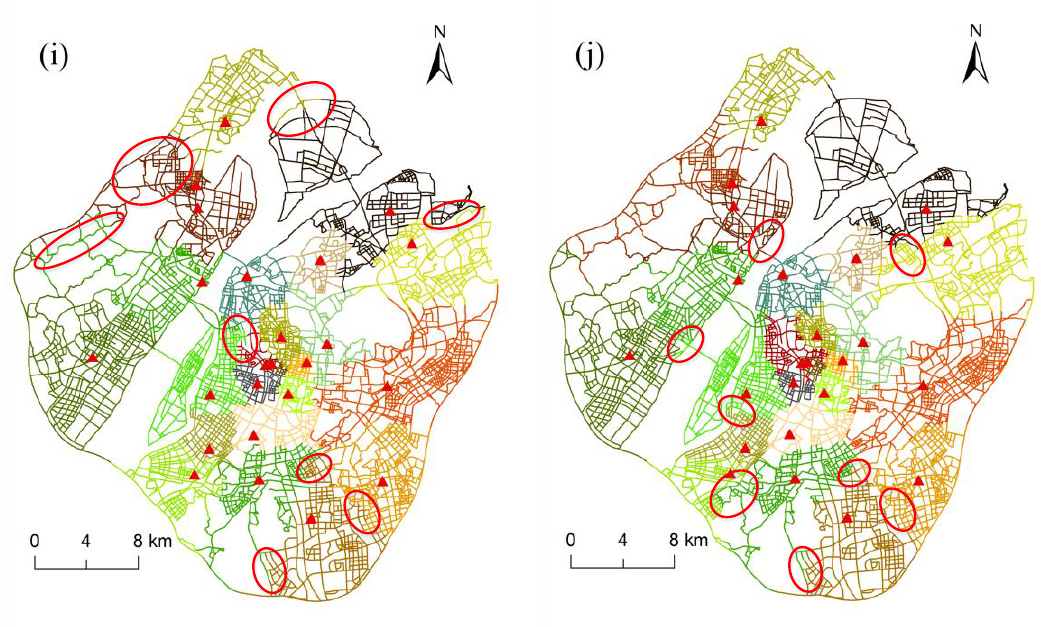
Figure 9. Dynamic service areas of fire stations by using monthly fire incident data from March to December 2015: ( a ) March, ( b ) April, ( c ) May, ( d ) June, ( e ) July, ( f ) August, ( g ) September, ( h ) October, ( i ) November, and ( j ) December. In each subgraph, the red ellipses highlight the difference between the results of this month and the results of the whole period (Figure 8b).